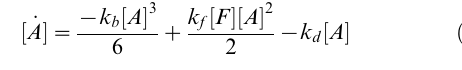
Figure 1 is a bifurcation plot that indicates the dynamics of the system that we have just described for different fixed concentra- tions of F . The ‘‘death’’ states are indicated by the red horizontal